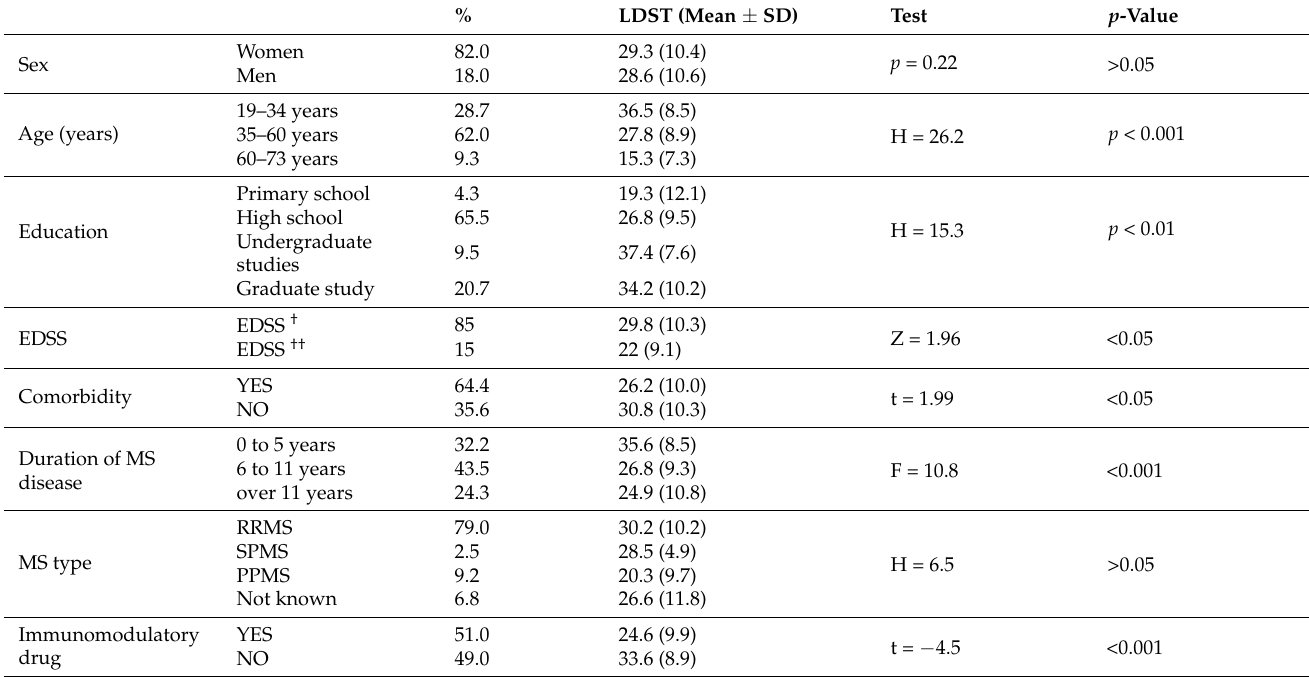
Table 2. Differences in LDST performance regarding relevant demographic and disease-related variables in pwMS.